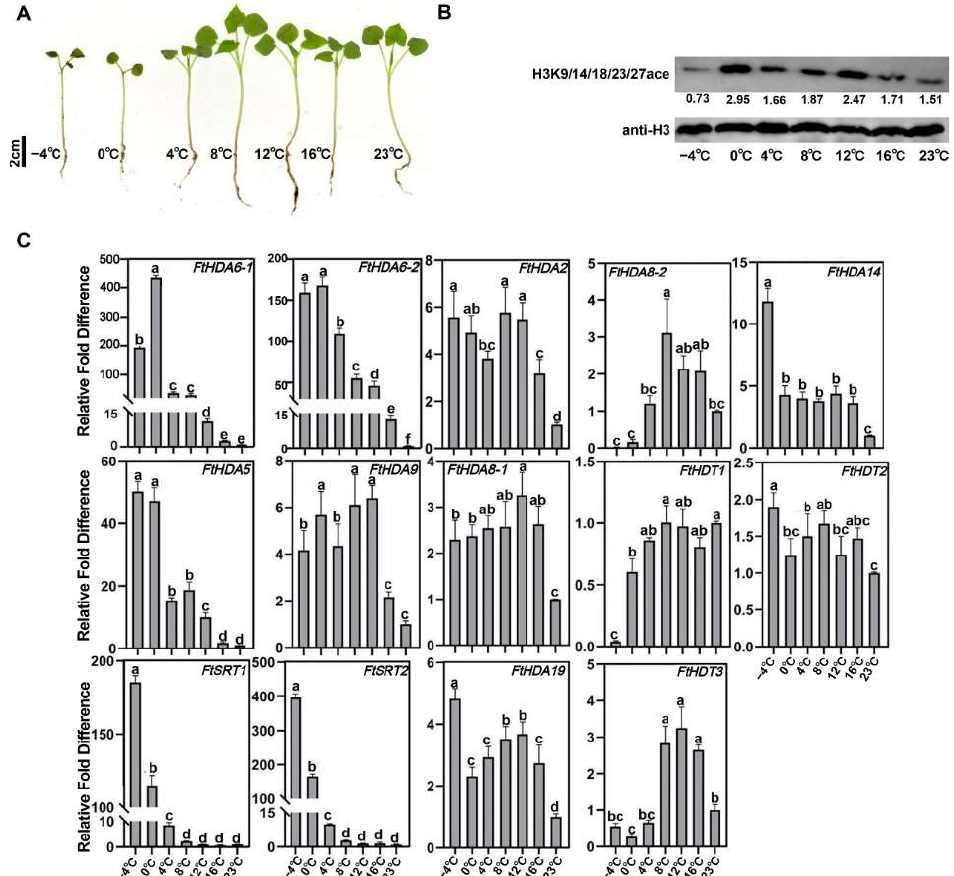
Figure 8. FtHDACs response to low temperature. ( A ) Phenotype of Dingku 1 displayed at different low temperatures. ( B ) The seedling of Dingku 1 treated in different low temperatures for 3 h then all recovered in 23 ◦ C at 36 h. Western blot analysis of the change in the global histone 3 acetylation levels after low temperature treatments. Histone H3 was used as an equal loading control. All immunoblots were replicated three times for each sample from three independent experiments. ( C ) mRNA enrichment analysis of Dingku 1 in different cold treatments was performed. Data are pre- sented as the means of three biological replicates (±SD). Different letters indicate significant differ- ences ( p < 0.05, Tukey’s test).